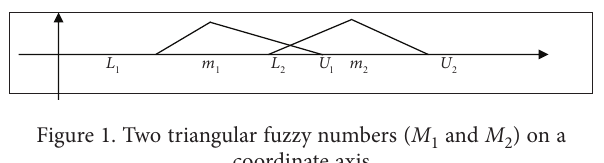
Figure 1. Two triangular fuzzy numbers ( M 1 and M 2 ) on a coordinate axis Table 1. Triangular Fuzzy scale definitions Linguistic scaleReciprocal